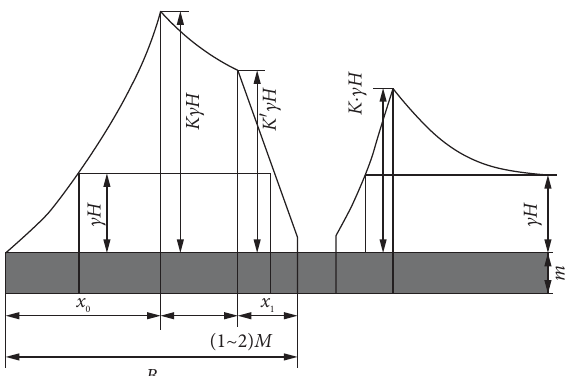
Figure 9: Elastic-plastic deformation zone and stress distribution of coal